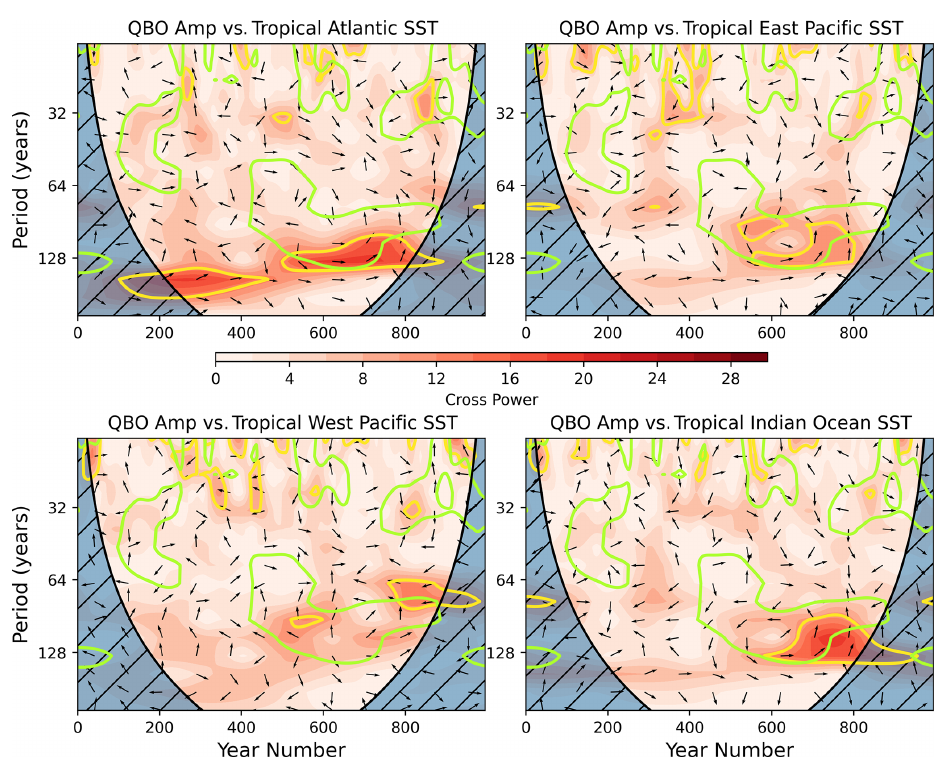
Figure A9. Cross-wavelet power spectra between September–November deep QBO amplitude modulation and September–November SST anomaly in each tropical